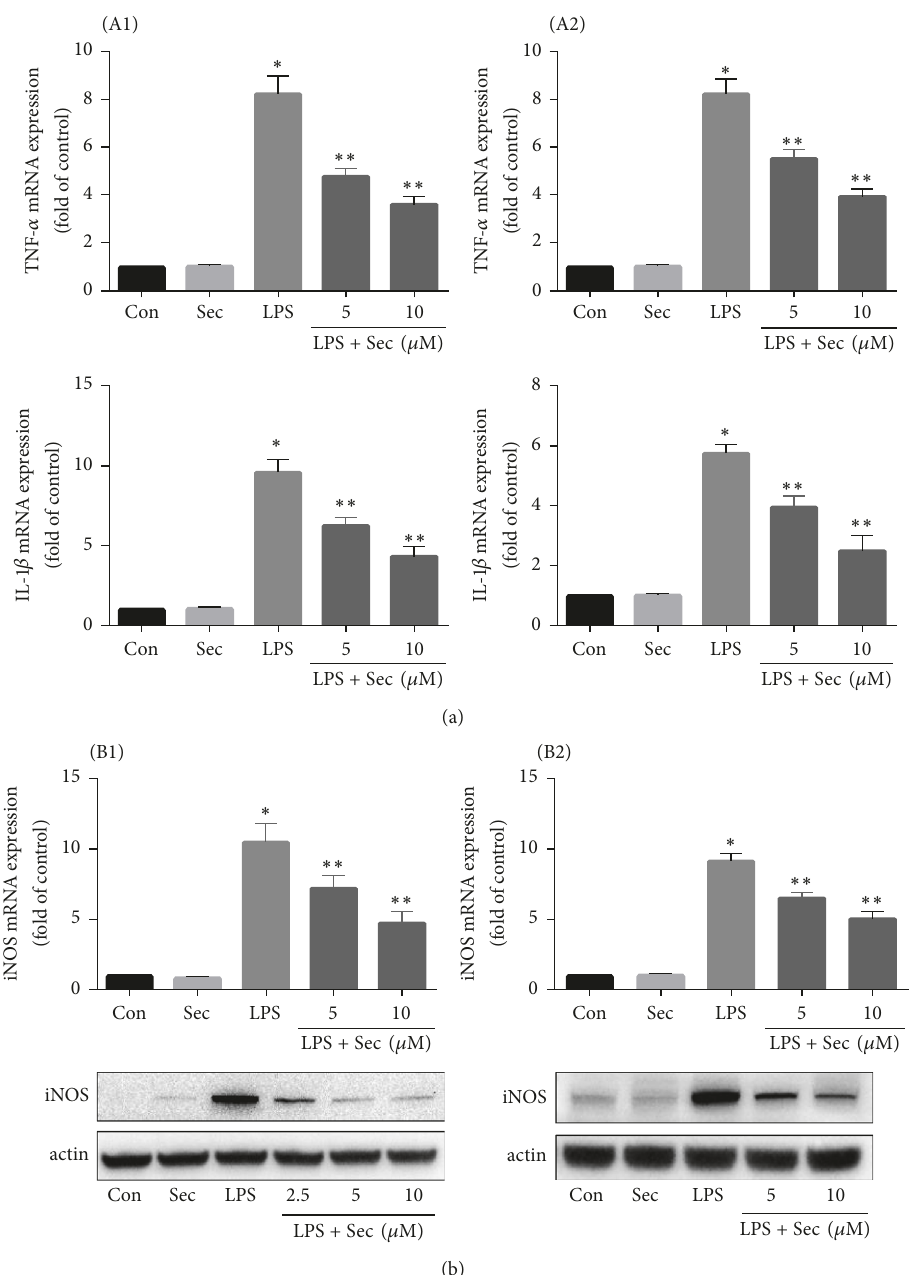
Figure 3: Securinine represses LPS-induced proinflammatory cytokines and iNOS expression in BV2 and mouse primary microglia. (a) Securinine inhibits proinflammatory cytokine expression following LPS exposure. BV2 and primary microglial cells were preincubated with securinine for 1h before stimulation with LPS (500ng/mL). After 6h of stimulation, total RNA was isolated and levels of mRNA expression of proinflammatory cytokines TNF- 𝛼 and IL-1 𝛽 analyzed via quantitative real-time PCR ((A1) BV2 cells and (A2) mouse primary microglia). (b) Securinine represses LPS-induced iNOS mRNA and protein expression in BV2 (B1) and primary microglia cells. After 24 h of stimulation with LPS (500 ng/mL), the level of iNOS protein was monitored by Western blot analysis ((B1) BV2 cells and (B2) primary microglia cells). Data are mean ± SD of three different experiments. ∗ 𝑃 < 0.001 versus control; ∗∗ 𝑃 < 0.05 versus LPS-treated group alone.